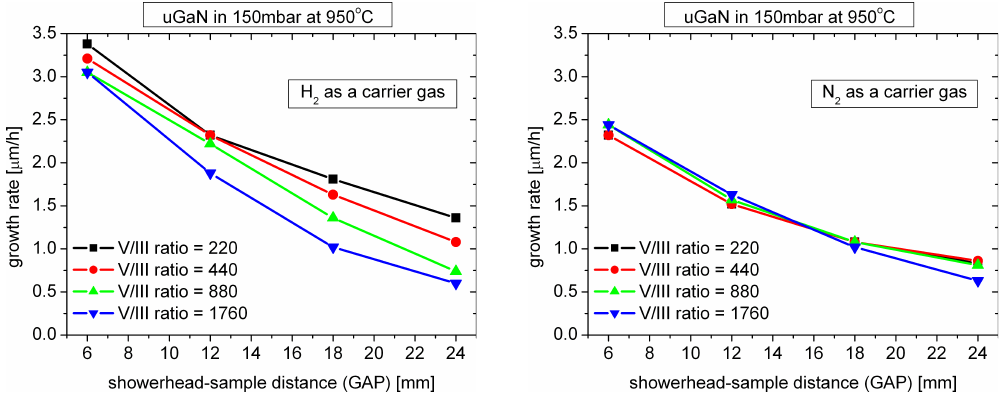
Figure 4. Growth rate of uGaN layers as a function of GAP distance for different V/III ratios (obtained for different NH 3